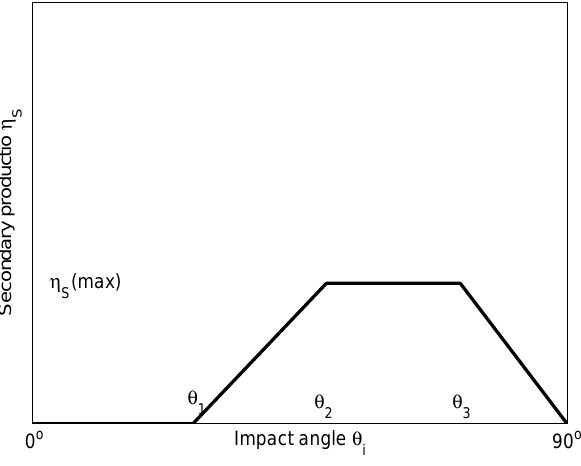
Fig. 11. The variation of effective area for secondary charge pro- duction as a function of payload rotation angle for different values of θ 3 (Fig. 10). The value of η S ( max ) used here is 1.